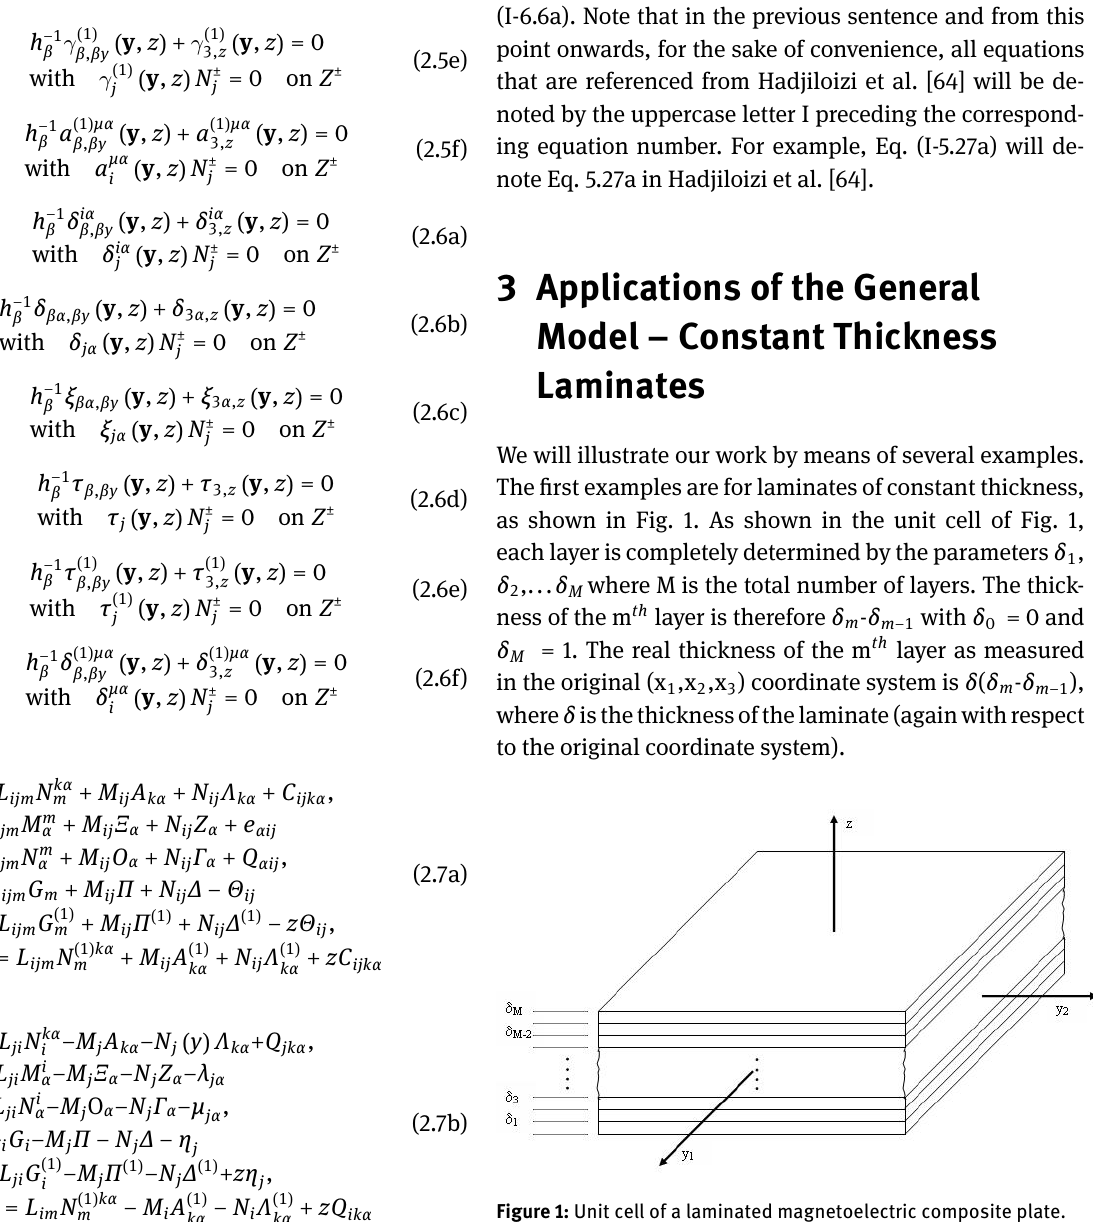
Figure 1: Unit cell of a laminated magnetoelectric composite